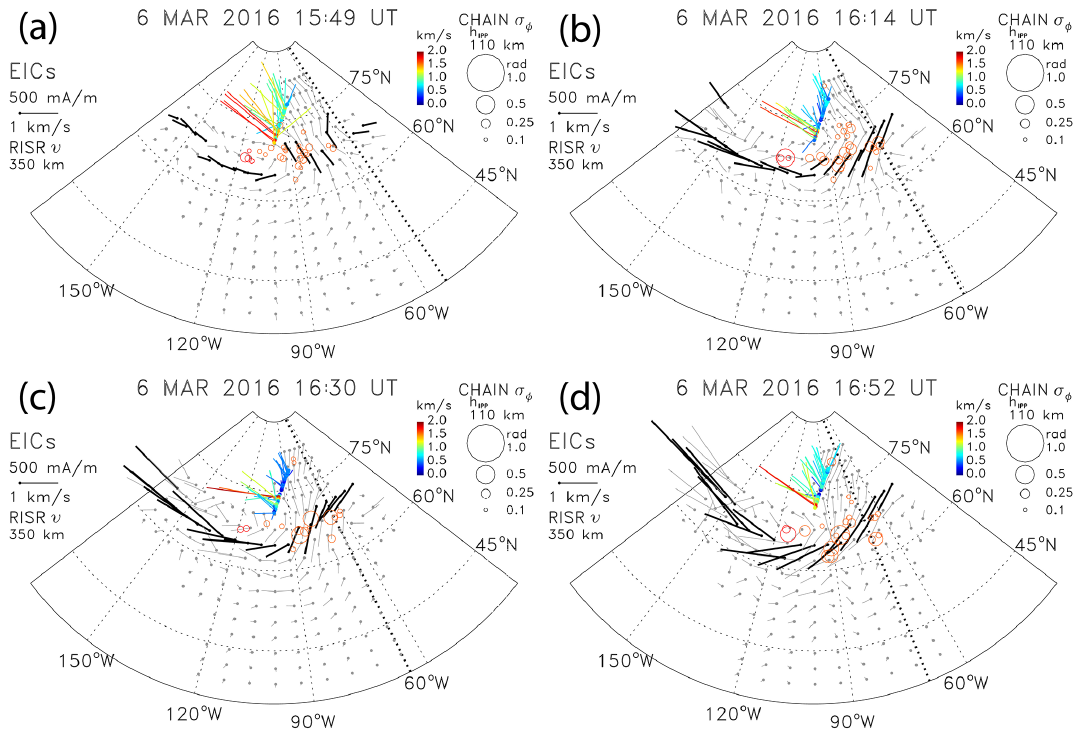
Figure 3. The horizontal EICs with their latitudinal maxima at each longitude grid, plasma flows observed by RISR (in color-coded veloci- ties), and the CHAIN GPS IPPs with enhanced phase-variation values, σ (cid:56) , (scaled circles). The bold dotted line shows the longitude of local